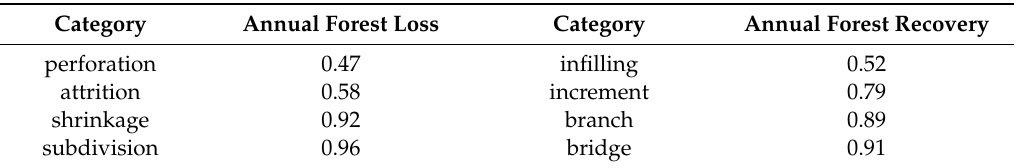
Table 7. Pearson correlation coe ffi cient between forest loss (recovery) and each type of the process model ( n =